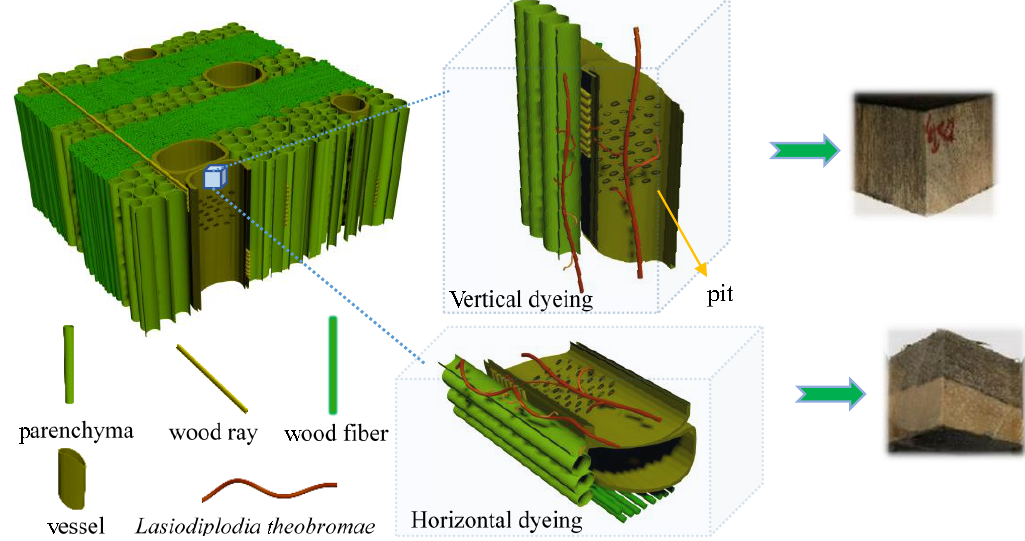
Figure 5. Infective characters of vertical and horizontal dyeing of poplar wood by Lasiodiplodia theobromae .